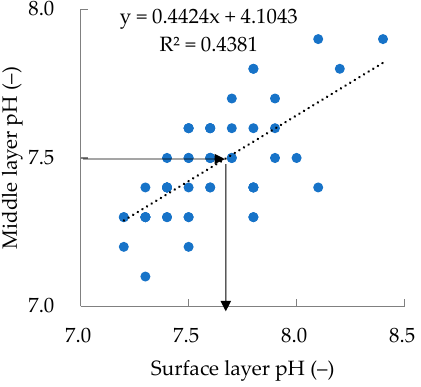
Figure 3. Correlation between surface and middle layer pHs of Sankyo RRR (2012–2020).